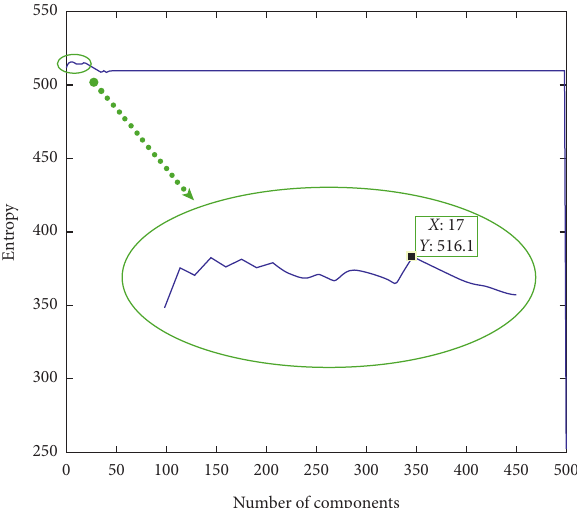
Figure 2: The selected optimal number of PCs.